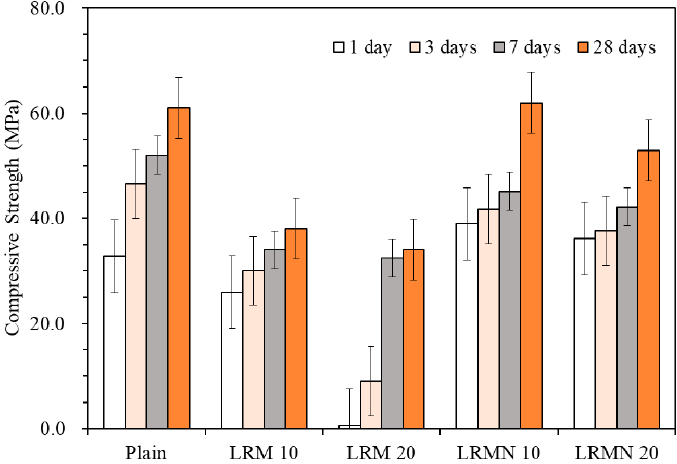
Figure 4. Compressive strength of the cement pastes with different compositions.